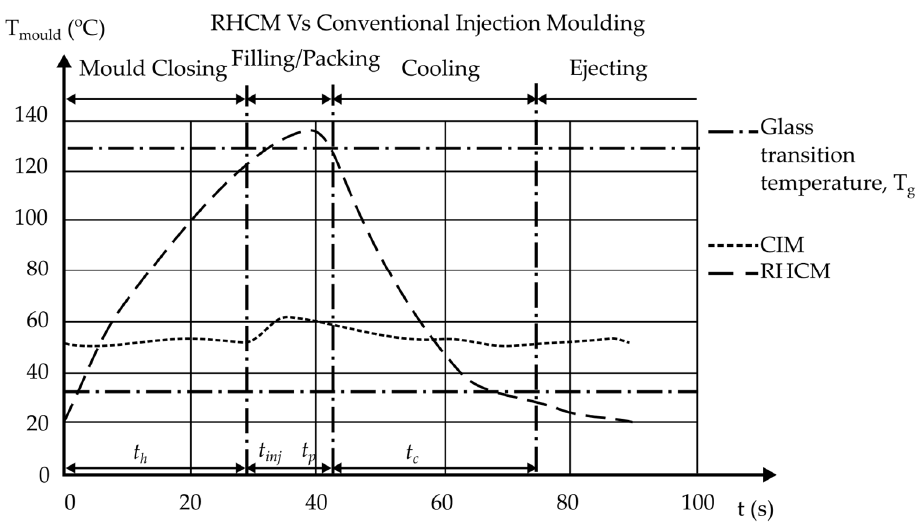
Figure 5. Example of mold temperature profile in RHCM